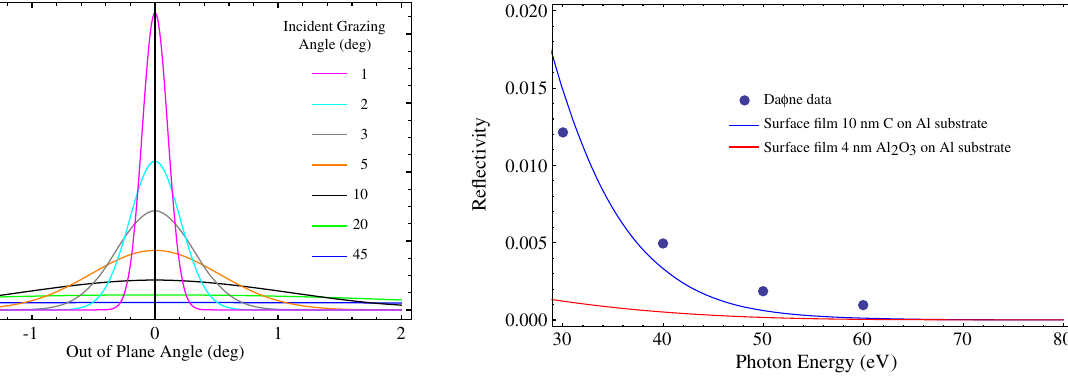
FIG. 8. Diffuse scattering out-of-plane angular distributions for high energy photons, σ ¼ 200 nm and T ¼ 5500 nm. The curves are calculated from the approximate relation given in Eq. (3). In this case, high-energy photons correspond to λ ≪ σ , i.e., E ≫ 6 eV.